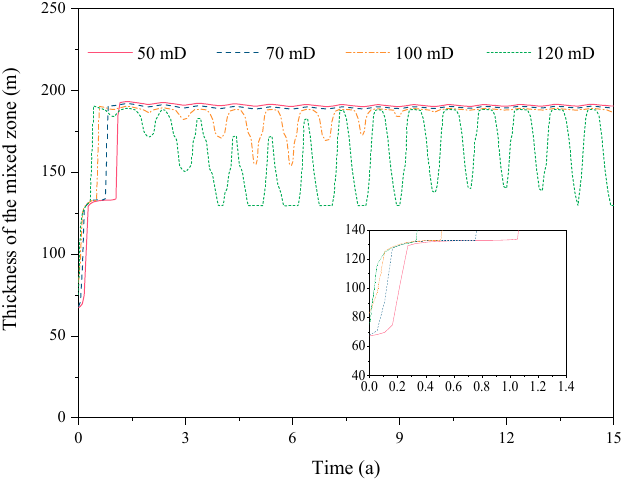
Figure 17. Thickness of the mixed zone for di ff erent reservoir horizontal permeabilities.